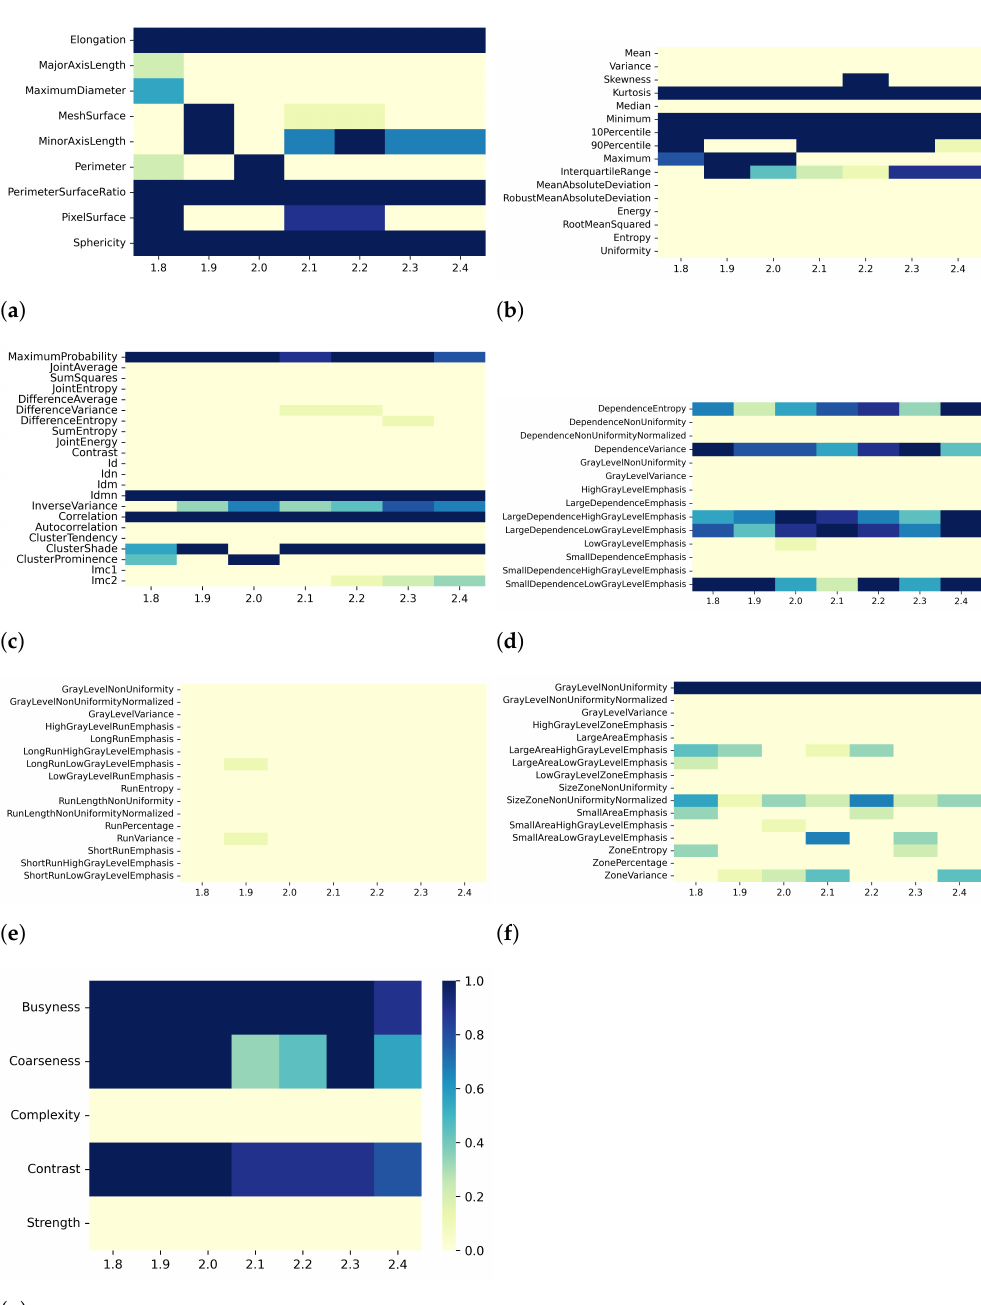
Figure 8. Heatmaps of remaining features from T2 maps after PCC-based dimensionality reduction for effect B (varying discretization bin width, with fixed resampling voxel size (mm)). The radiomic features are separated in classes: ( a ) 2D shape, ( b ) first order, ( c ) GLCM, ( d ) GLDM, ( e ) GLRLM, ( f ) GLSZM, ( g )